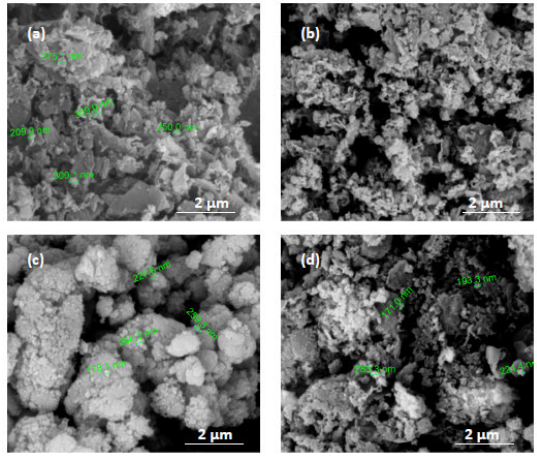
Fig. 6 SEM images after FT assisted synthesis and leaching with 1.5 M HCl: (a) and (c) ZrB 2 from ZRBC2.5 and ZRBC1.6 respectively, (b) and (d) (ZrB 2 +SiC) from ZRBC2.5+Si and ZRBC1.6+Si respectively.